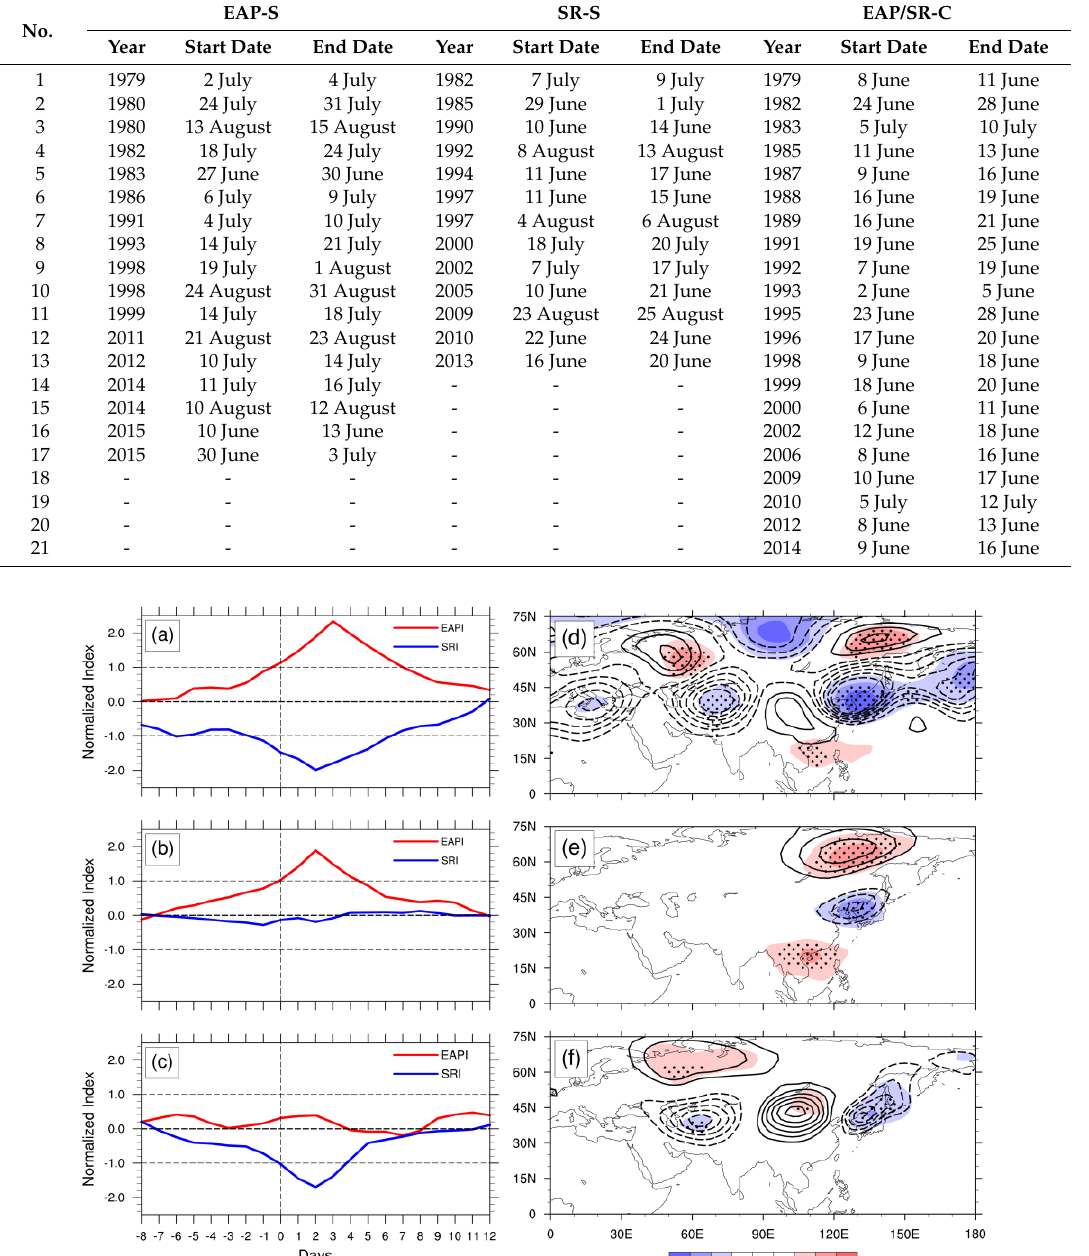
Table 1. The years, start dates, and end dates of single EAP (EAP-S), single SR (SR-S), and combined EAP and SR (EAP/SR-C) events.